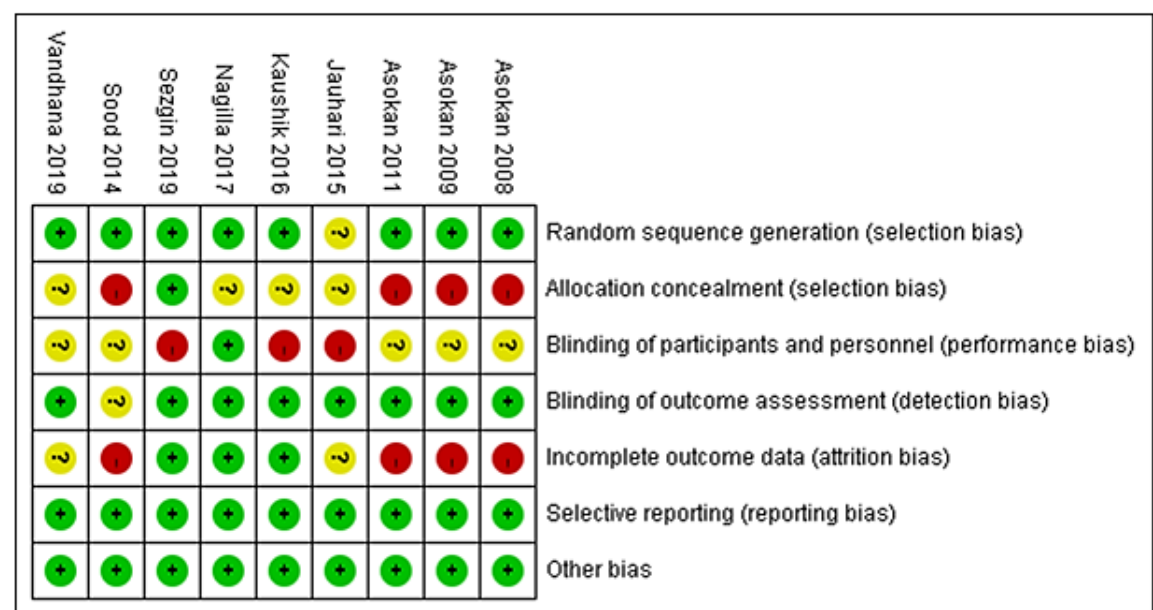
Figure 2. The risk-of-bias assessment results of the nine included trials.